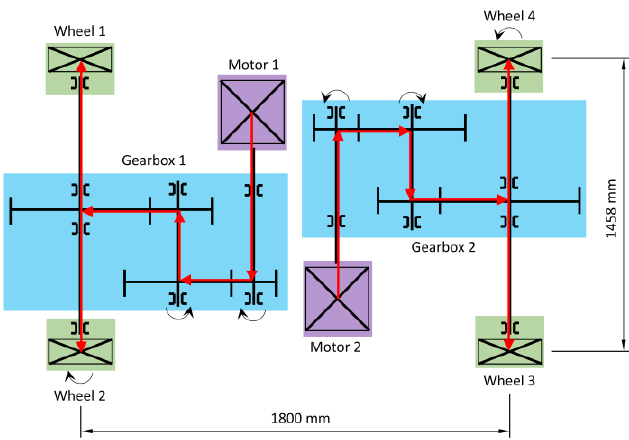
Figure 1. Schematic diagram of the investigated motor bogie.